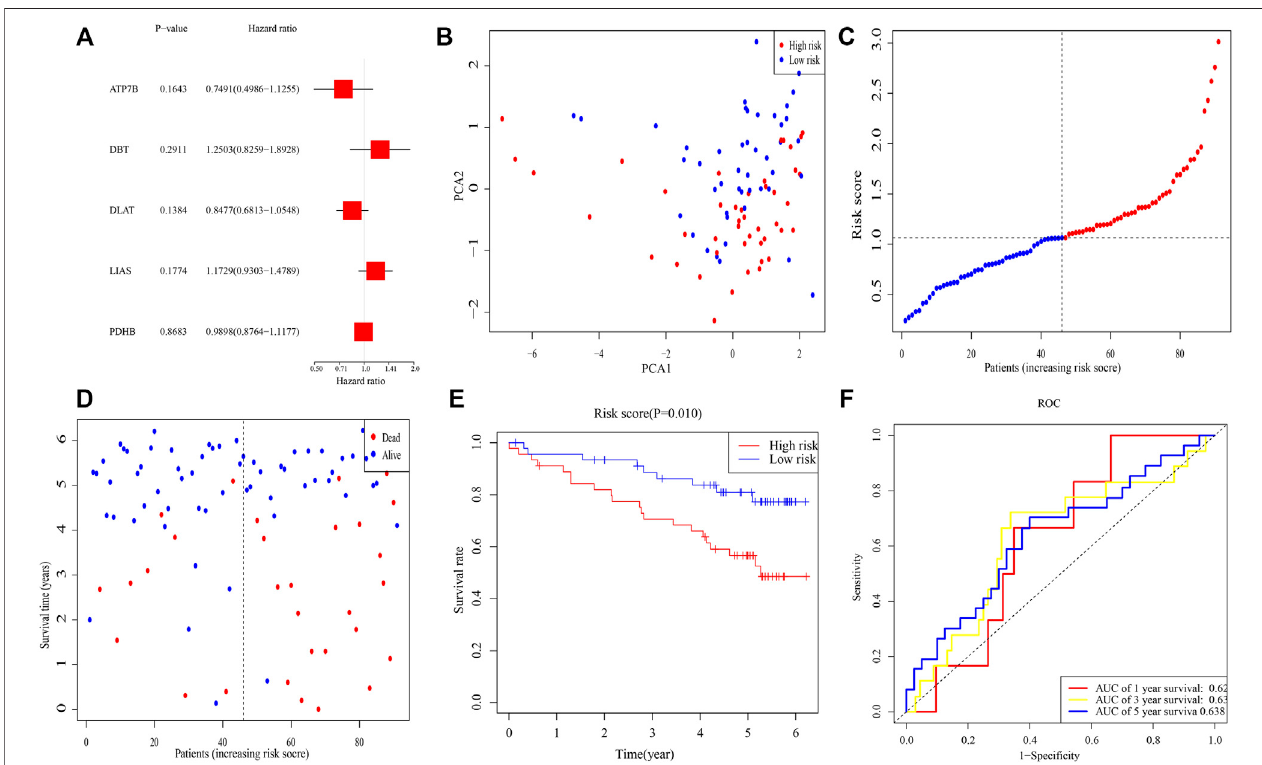
FIGURE3| ValidationoftherisksignatureinICGC. (A) MultivariableCoxregressionanalysisofthe fi vegenesdeterminedbylassoregressionanalysis. (B) PCAplot of patients with ccRCC. (C) Distribution of ccRCC patients based on the signature. (D) Distributions of OS status, OS, and risk scores. (E) K-M curves for OS of ccRCC patients in risk subgroups. (F) AUC of time-dependent ROC curves.